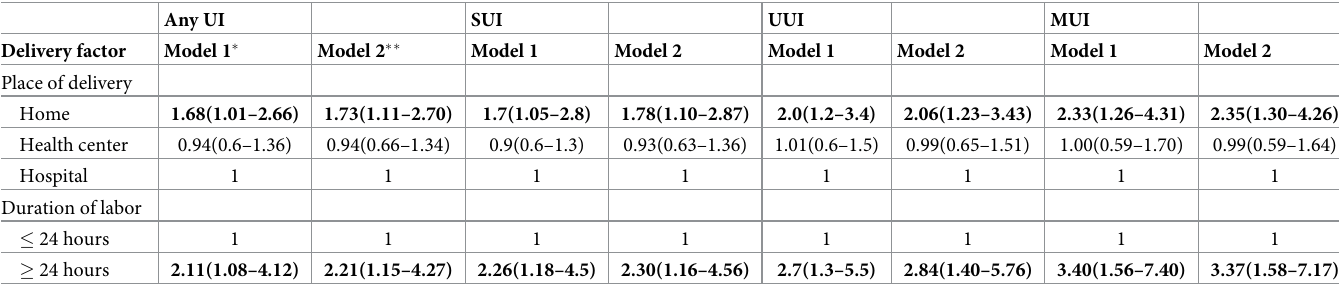
Table 4. Delivery factors associated with different urinary